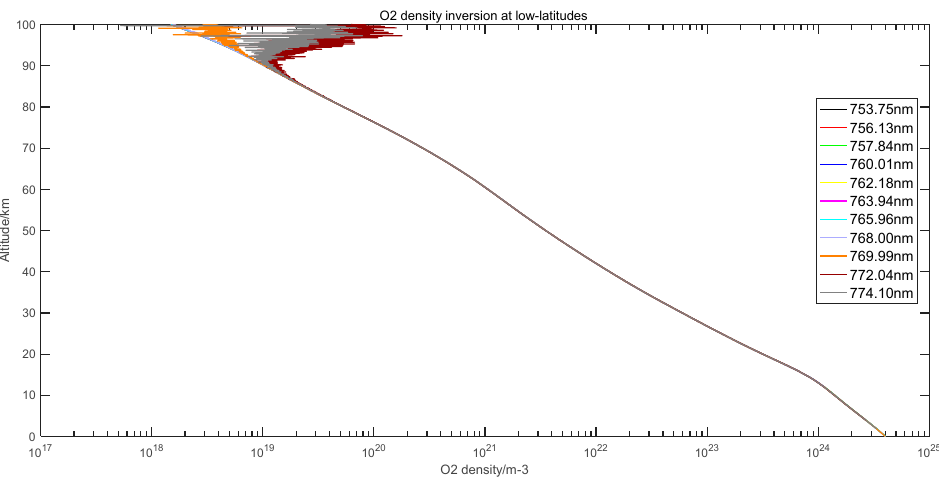
Figure 4. Inversion results of oxygen number density at different wavelengths.